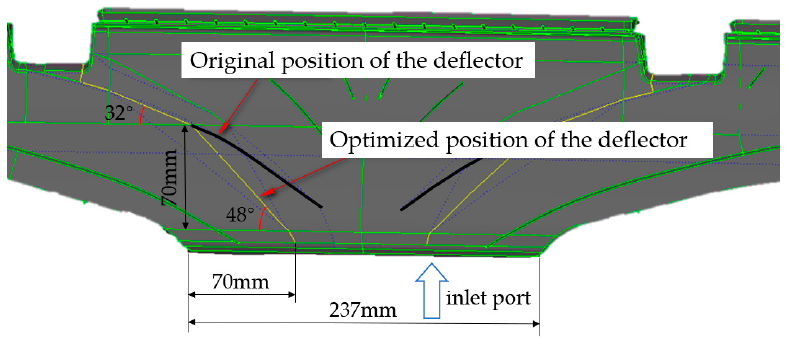
Figure 7. Original and optimized wind duct geometry.